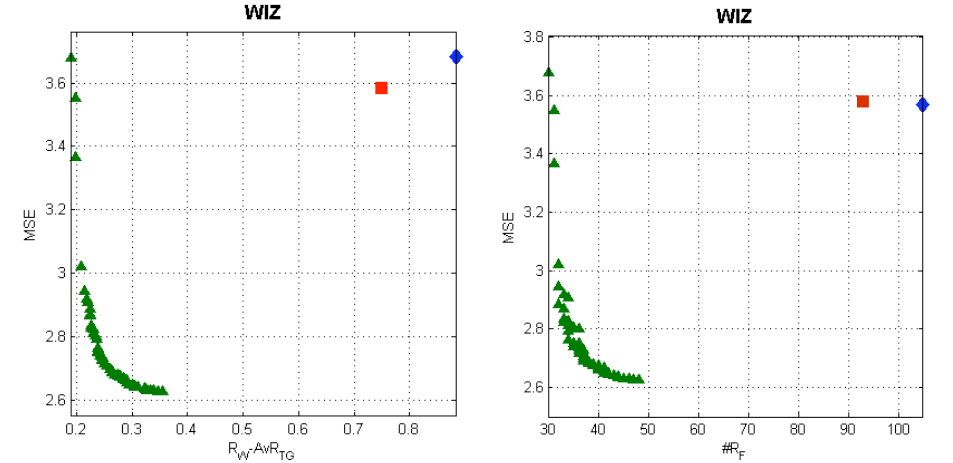
Fig. 4. Example Pareto fronts obtained in WIZ problem.